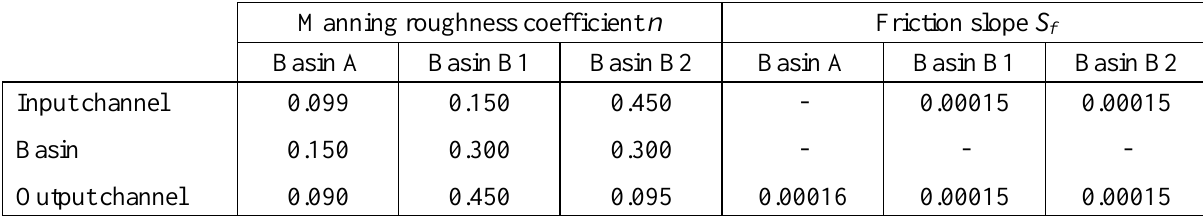
Figure 6. Daily TE (%) and daily rainfall for basins B1–B2 in series. Table 3. Manning roughness coefficients for 1 D hydraulic models of the studied